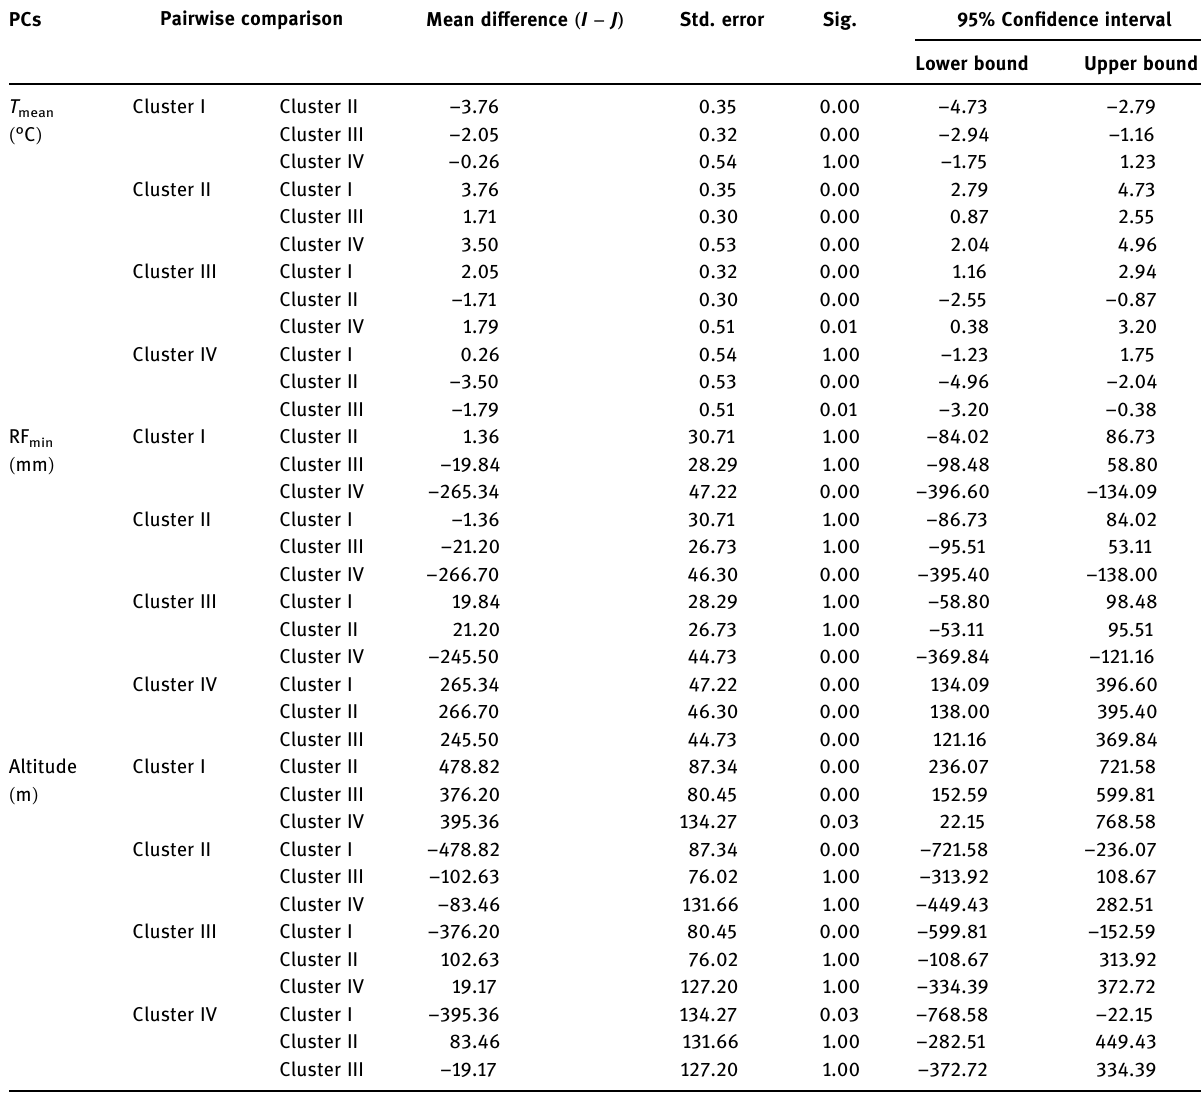
Table 8: Multiple comparisons and post hoc tests of PCs in FMAM season